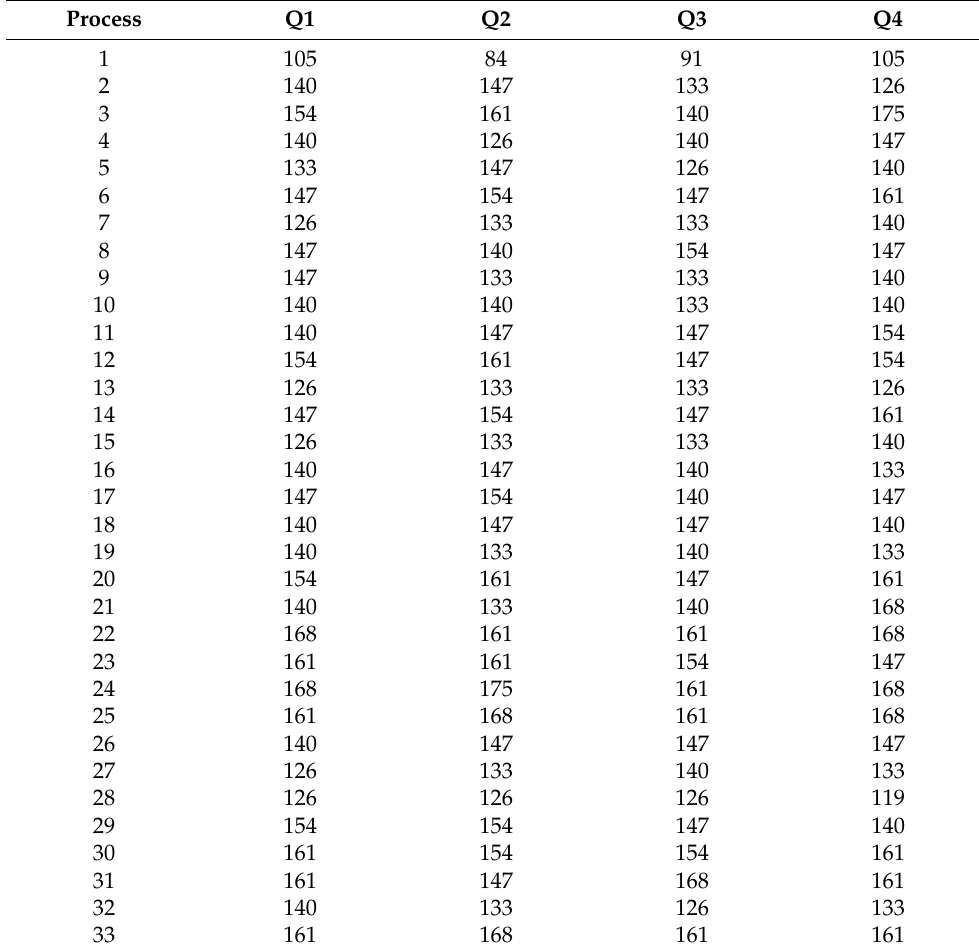
Table 4. Product final assembly process and